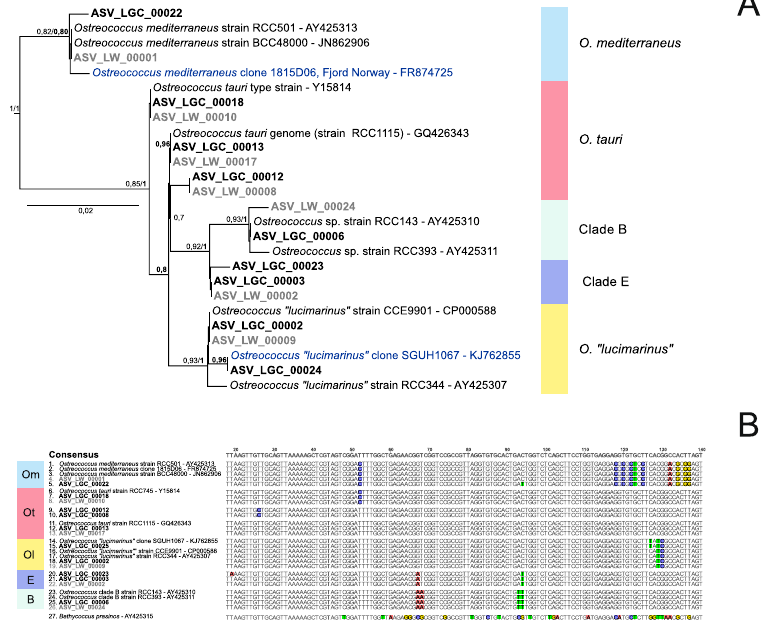
Figure 2. Phylogenetic diversity within the genus Ostreococcus . ( A ) Phylogenetic tree of 26 Ostreococcus sequences from the V4 region of the 18S rRNA gene (FastTree). The tree was rooted with B . prasinos . Only ML bootstrap values higher than 70% are represented. Bayesian posterior probabilities are in bold. ASVs are in bold: black for the LGC dataset and gray for the LW dataset. Only ASVs represented by more than 200 reads were taken into account. Environmental GenBank sequences are in blue. ( B ) Alignment of 26 Ostreococcus V4 regions: the alignment is 341 bp long, but only the main signatures are shown (between positions 20 and 140 of the original